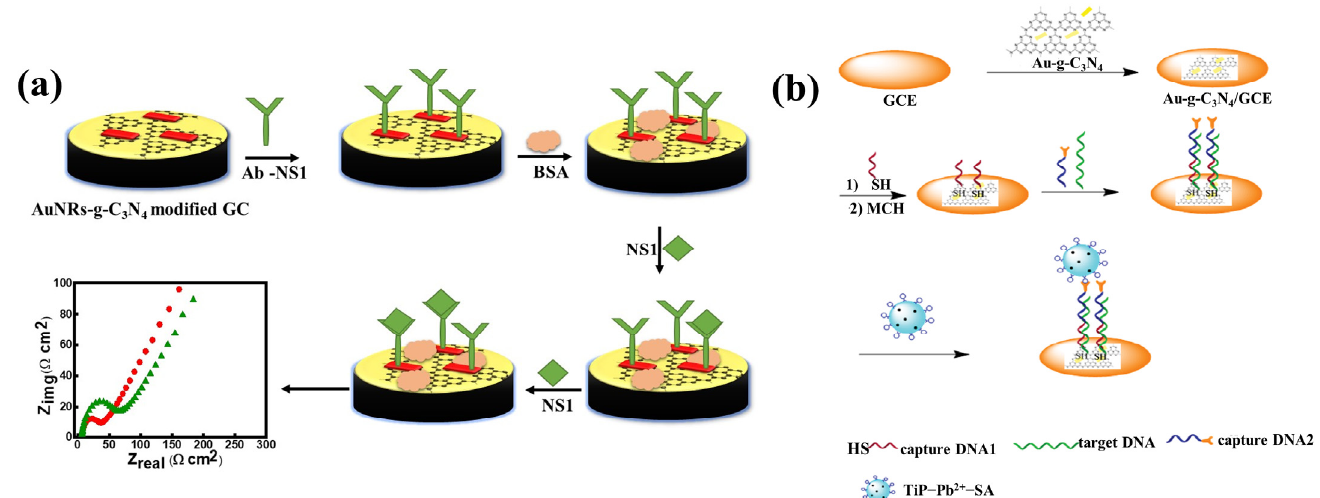
Figure 3. ( a ) Fabrication of NS1 immunosensing platform by using graphitic carbon nitride and gold nanorods; reproduced with permission from [47]. ( b ) Stepwise construction of immunosensing platform utilizing gold nanorods and graphitic carbon nitride for detection of chronic lymphocytic leukemia. Reproduced with permission from